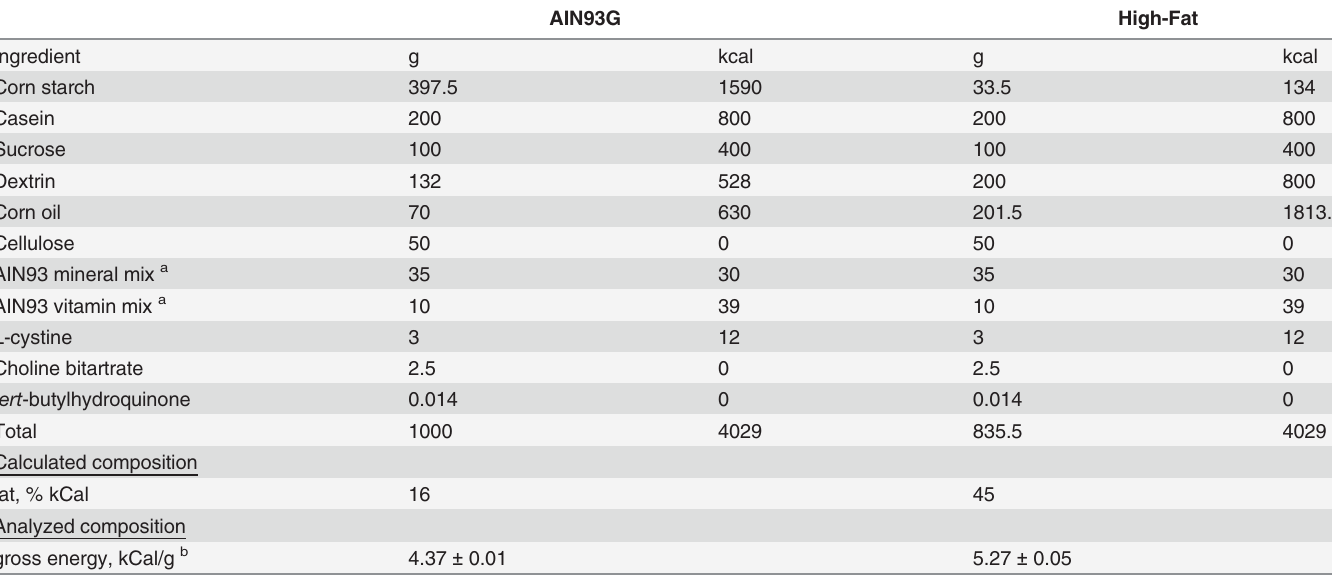
Table 1. Composition of experimental